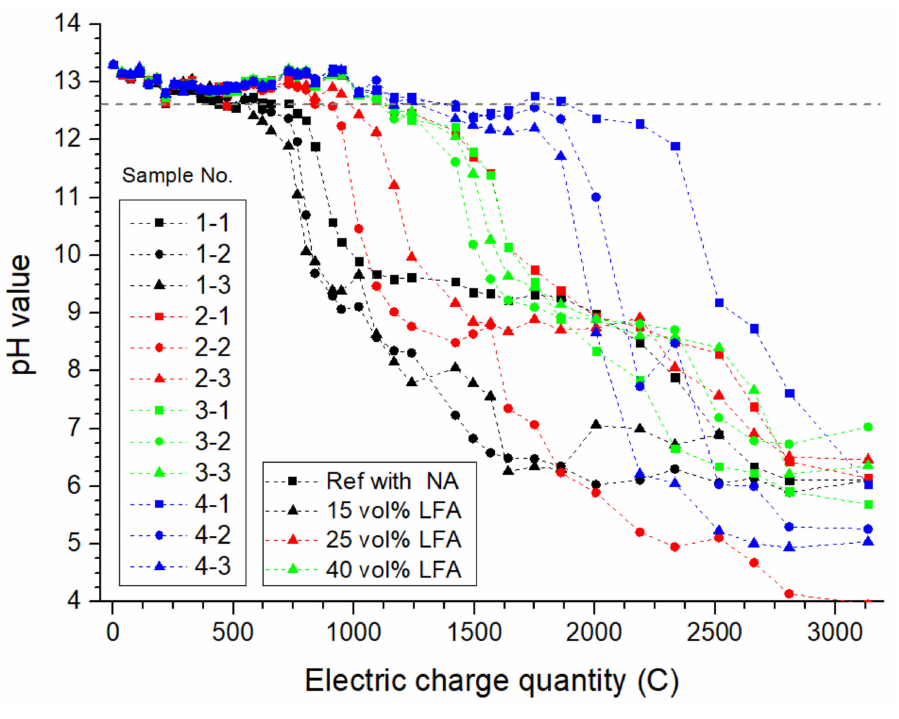
Figure 3. The monitored pH values of simulated concrete pore solution in all anode cells.